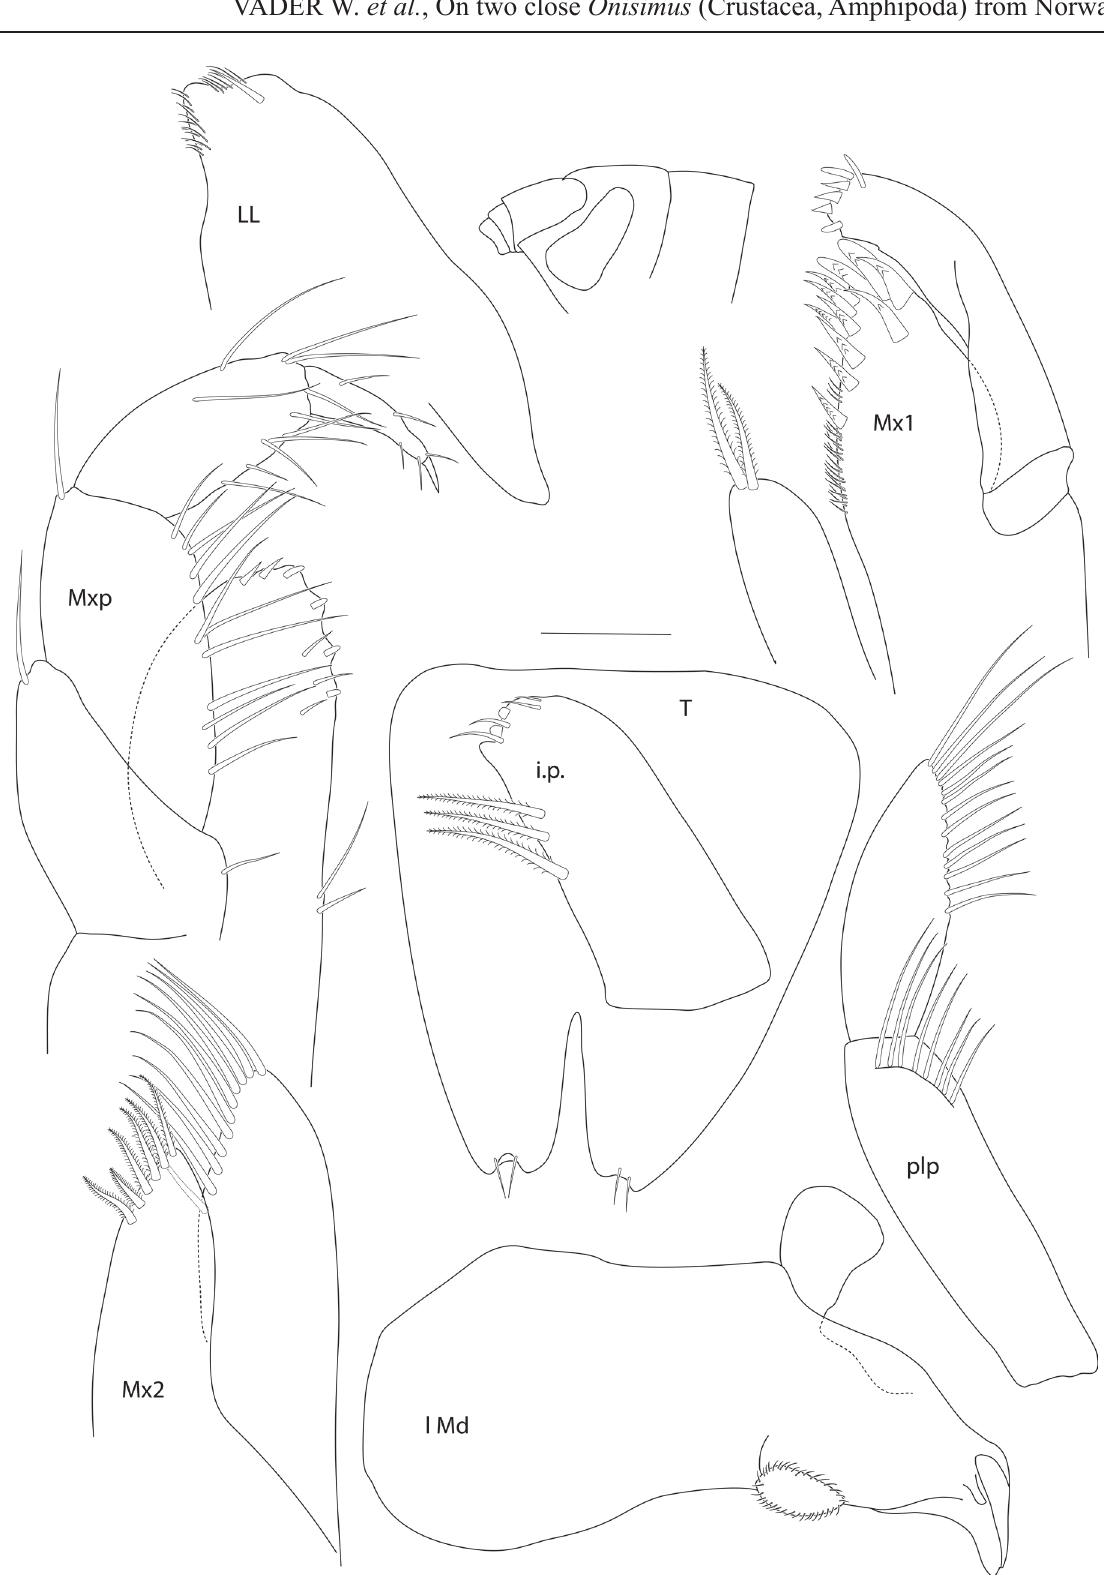
Fig. 1. Onisimus normani Sars, 1890, ♀, 10 mm, Korsfjorden, Norway (TSZCr8659). Head, mouthparts (l mandible, lower lip, maxilla 1, maxilla 2, maxilliped), telson. Abbreviations: see Material and methods. Scale bars = 0.1